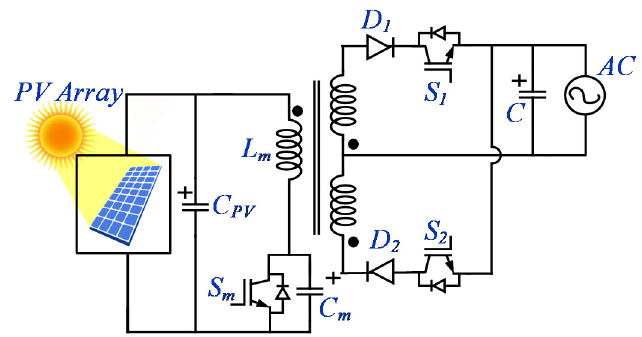
Figure 24. Single stage fly-back inverter with soft switching .